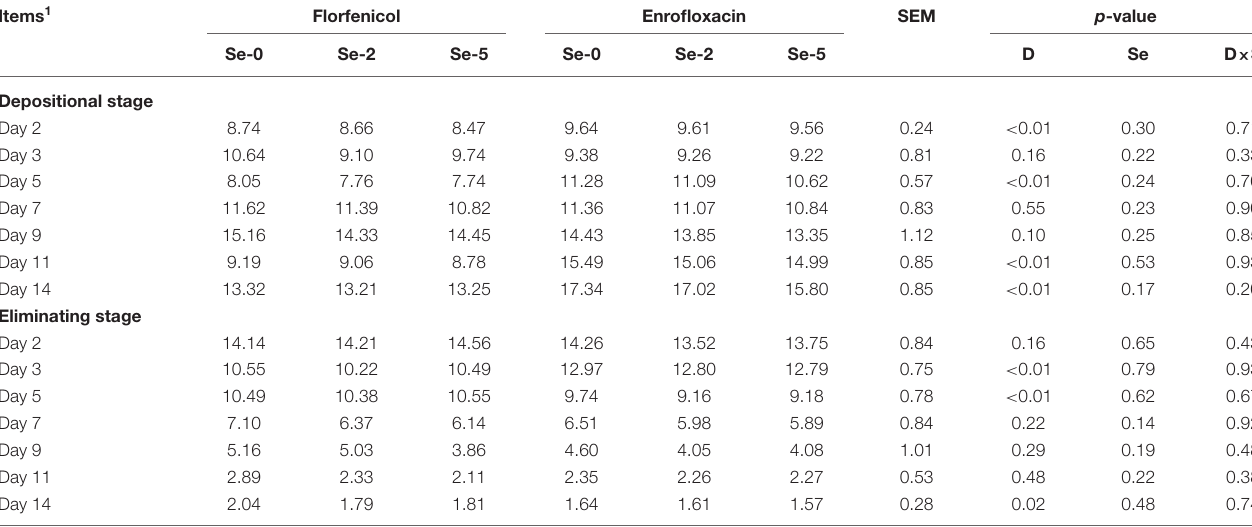
TABLE 6 | Effects of dietary organic selenium on residue of drugs in kidney of laying hens. Items 1